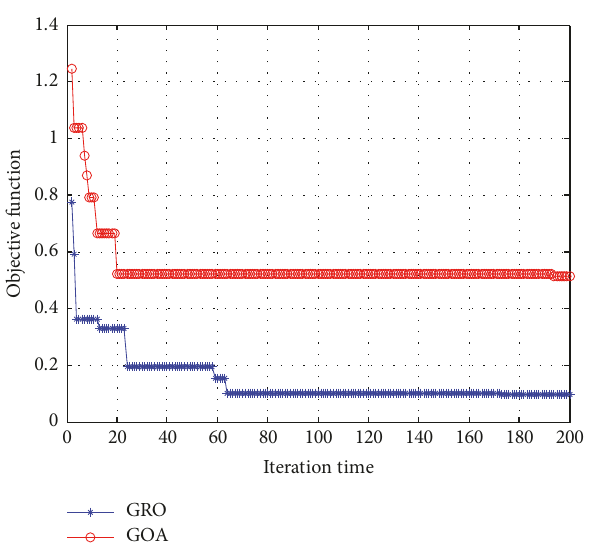
Figure 10: Convergence performance